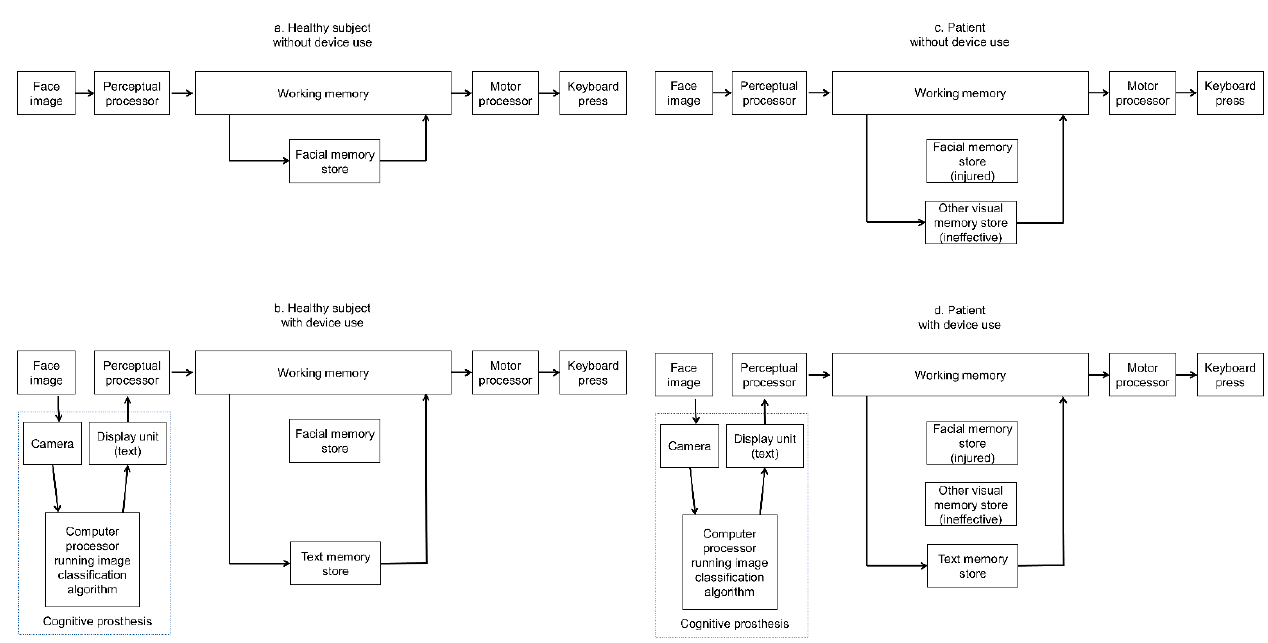
Figure 5. Model human processor schematics for healthy subjects undergoing the acquaintance face recognition test with ( a ) and without ( b ) cognitive prosthesis device use. Schematics for the patient with ( c ) and without ( d ) cognitive prosthesis device use are also shown.